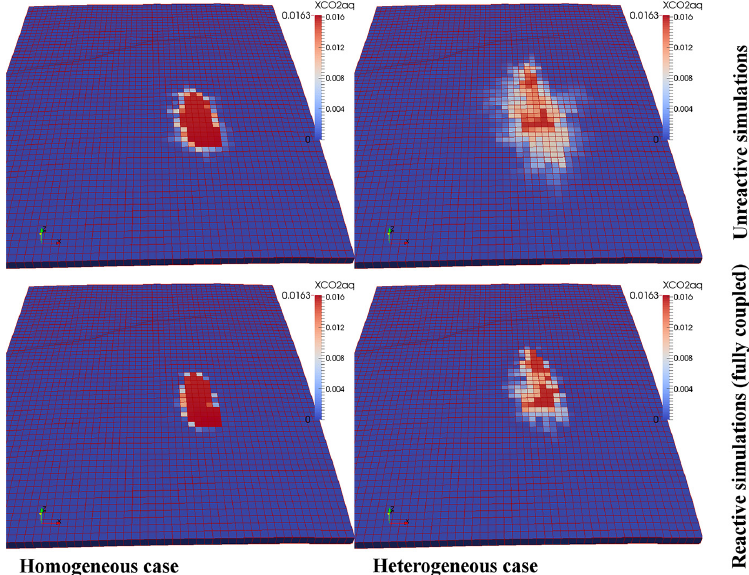
Figure 3. Spreading of dissolved CO 2 in terms of aqueous mass fraction (XCO2aq) after 2100 years. Compared are the homogeneous (left column) and heterogeneous (right column) cases; first row shows the non-reactive and second row the reactive simulations (full coupling). At this simulation time there is a significant difference between the reservoir volume affected by dissolved CO 2 depending on whether or not chemistry is included in the simulation. Since the simplified coupling makes use of non-reactive simulations to estimate the exposure time of each element, this discrepancy will impact its outcome. However, this effect is mitigated by the introduction of a threshold filtering out small concentrations of aqueous CO 2 as geochemically inactive (see text for further details).